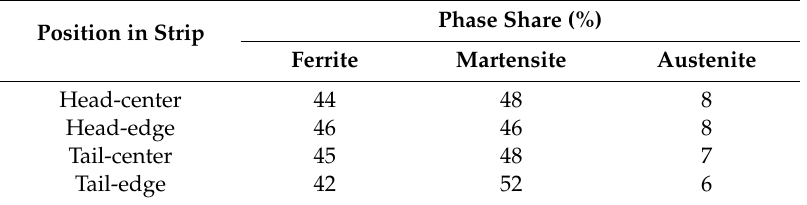
Table 2. Quantitative evaluation of phases at various positions in the col after hot-dip galvanizing. Phase Share Position in Strip